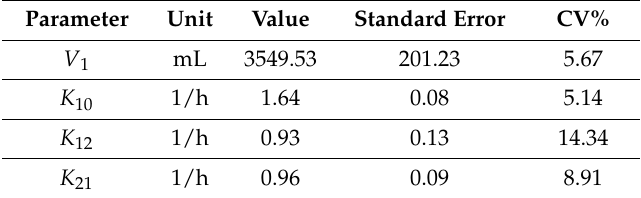
Table 4. Disposition parameters of DKT for a two-compartmental pharmacokinetic (PK) model: V1 represents the central compartment volume; K 10 represents a first-order elimination rate constant; K 12 and K 21 reflect the two rate constants distributing the drug between the peripheral and central compartment,